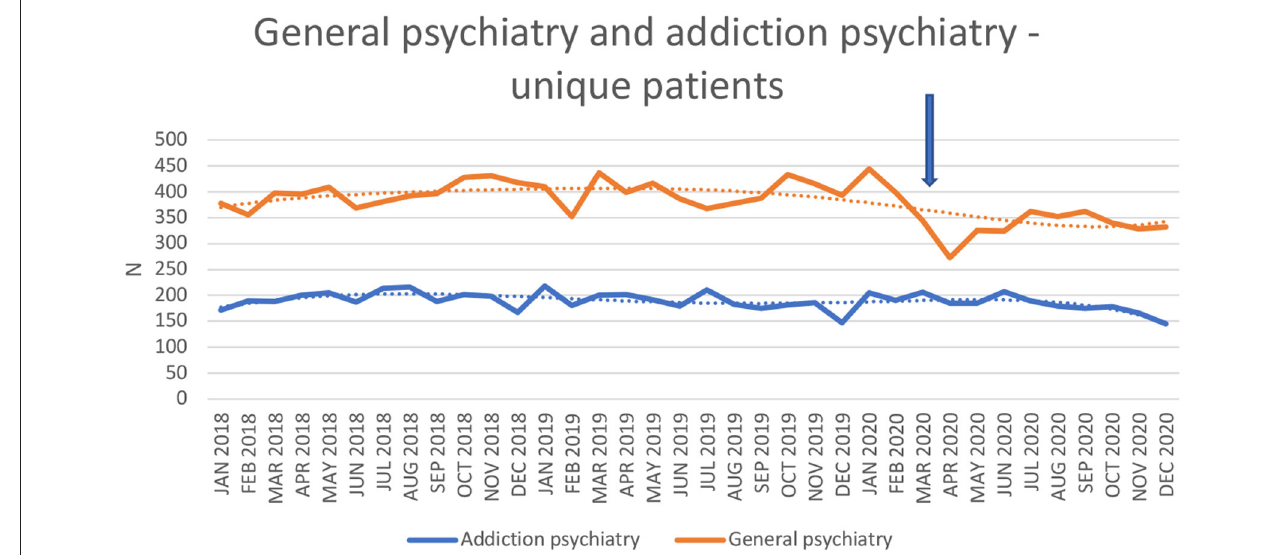
FIGURE 2 | Number of unique patients in general emergency psychiatry and addiction emergency psychiatry.